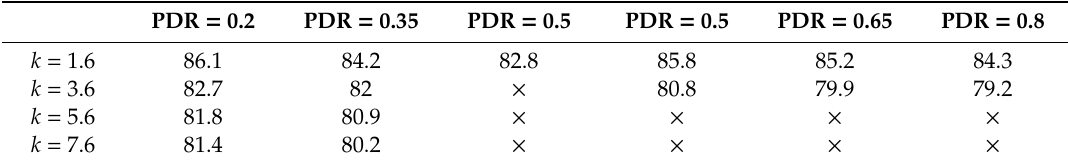
Table 5. The overall e ffi ciency of rotary tillage